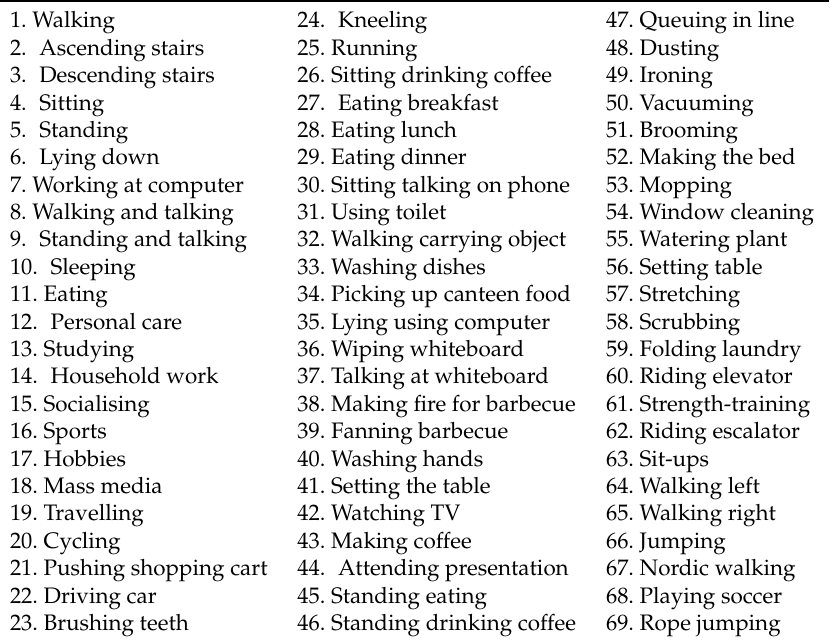
Table 1. Activities found ADL studies using